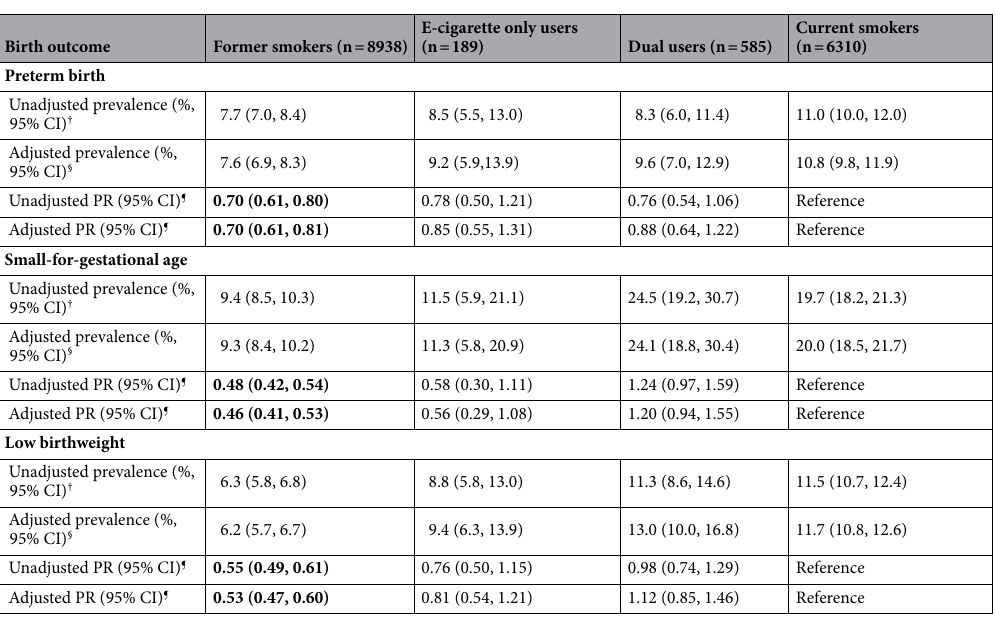
Table 3. Prevalence of select birth outcomes by self-reported electronic cigarette (e-cigarette) use and combustible cigarette smoking during the last 3 months of pregnancy among US women (N = 16,022)— Pregnancy Risk Assessment Monitoring Survey,* United States, 2016–2018. Bolded text indicates significant at p < 0.05. *PRAMS sites included in this analysis are: Alaska (2016–2018), Alabama (2017), Arkansas (2016),